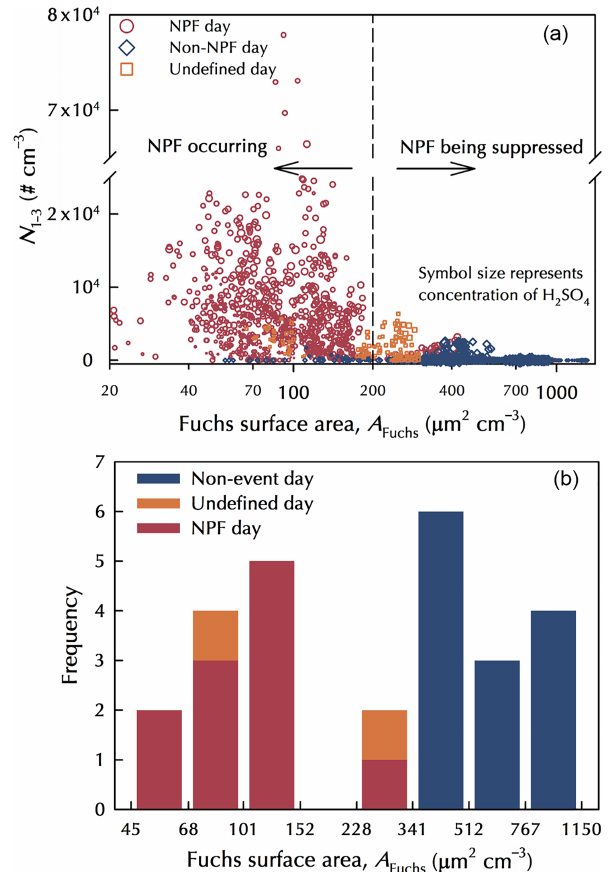
Figure 5. (a) The relationship between Fuchs surface area and num- ber concentration of 1–3nm particles, N 1 − 3 . The relative concen- tration of measured sulfuric acid is represented by symbol size; i.e., the higher the relative concentration, the bigger the symbol size. Data points are 5min resolved. (b) Frequencies of observed NPF days, undefined days, and non-event days in comparison to the daily-average A Fuchs . On typical NPF days and undefined days, A Fuchs was averaged during NPF event periods. On non-event days, it was averaged between 08:00 and 16:00. A Fuchs values were binned in a logarithmic scale ranging from 45 to